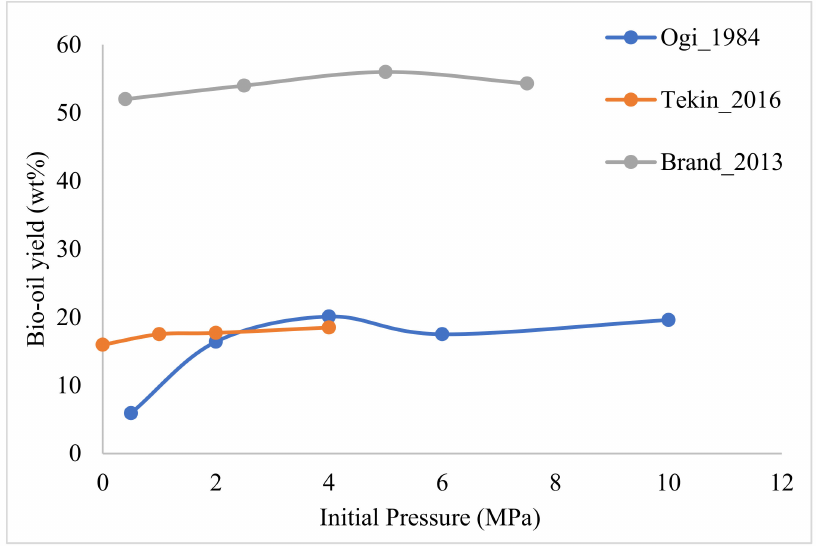
Figure 6. Effect of initial pressure in reactor on the yield of bio-oil (inert